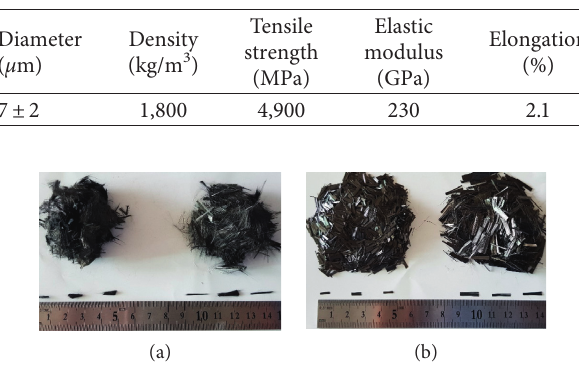
Figure 2: Shapes of carbon fibers used in this experiment: (a) SiO coated carbon fibers (6mm and 12mm) and (b) uncoated carbon fibers (6mm and 12mm).